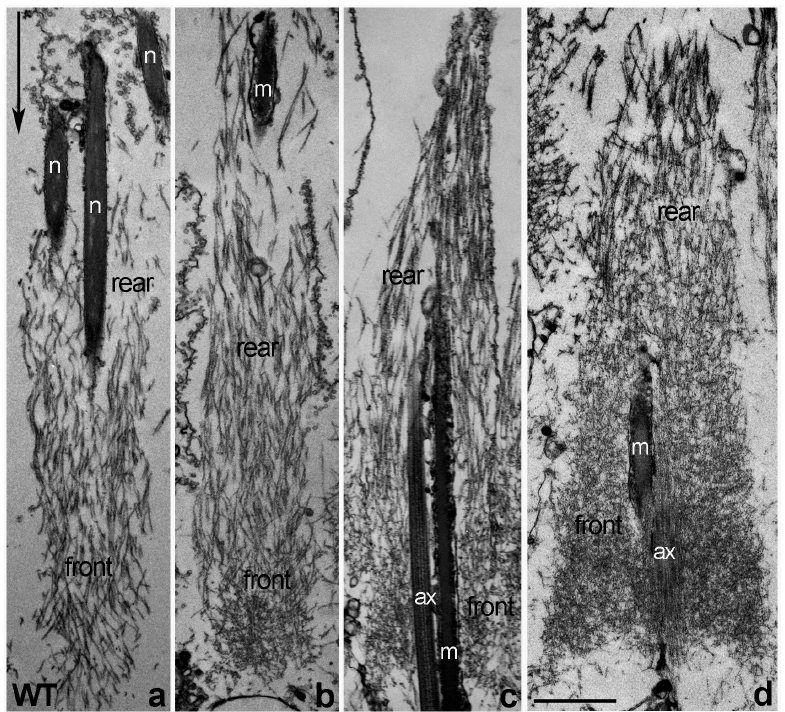
Figure 5. Ultrastructure of S1-decorated WT actin cones—longitudinal sections. Newly forming actin cones (in association with spermatid nuclei) are composed of actin bundles parallel to the longitudinal axis of the cone ( a ). A small actin meshwork is visible at the front of the early cones that have just moved a little away from the nuclei ( b ). Individualized actin cones have two structural domains ( c , d ): the rear domain is composed of actin bundles and the front domain is composed of a dense actin meshwork; as the cones move farther away from spermatid nuclei, the amount and extent of meshwork increases (( d ) vs. ( c )). Arrow in ( a ) indicates the direction of actin cones movement during individualization. Bar 1 µm.